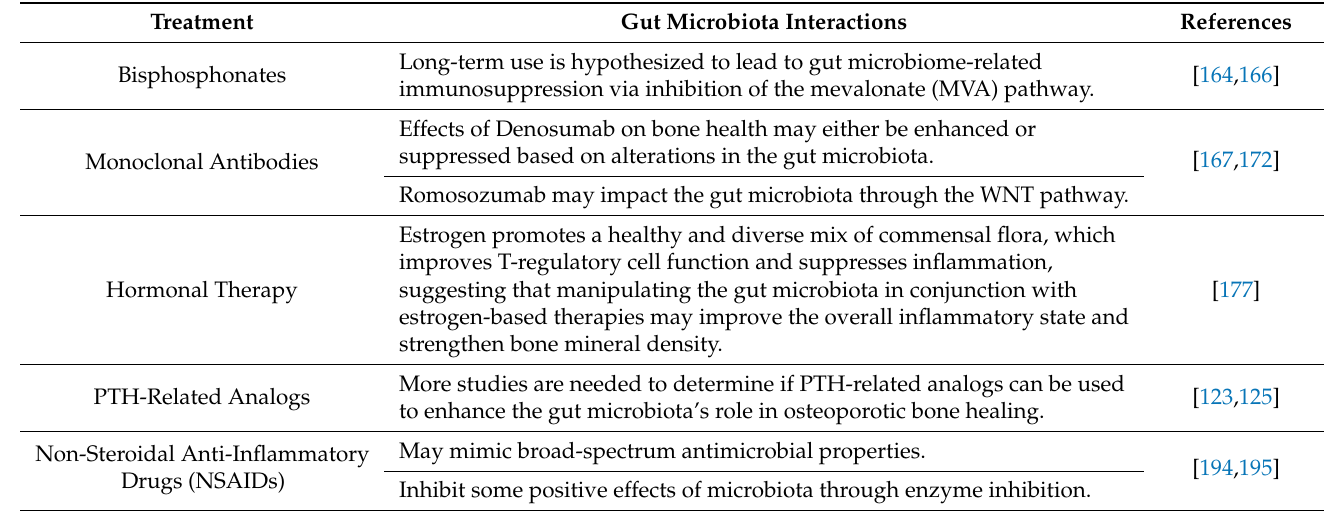
Table 2. Hypothesized or known interactions between osteoporosis drug classes and gut microbiota.